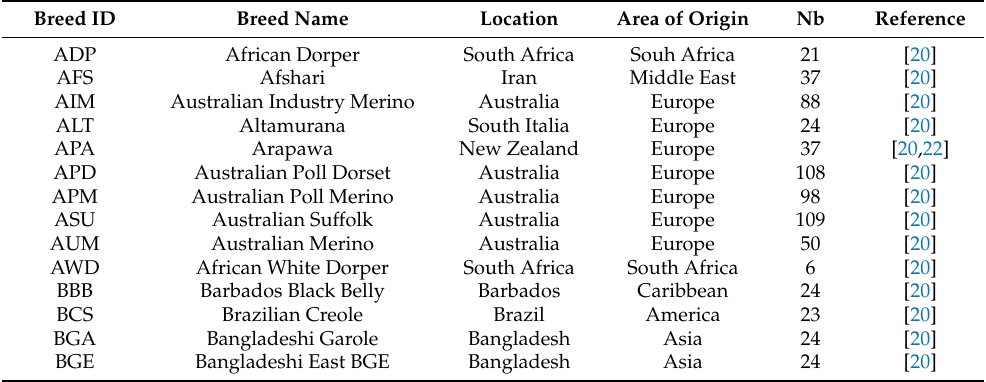
Table 1. List of the sheep breeds of the WORLD-Set considered in the current study. Breed